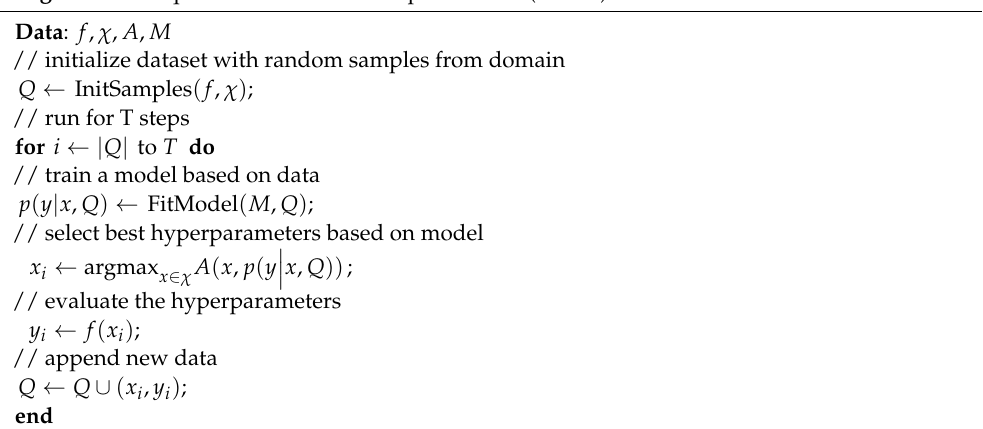
Algorithm 1 Sequential Model-Based Optimization (SMBO)